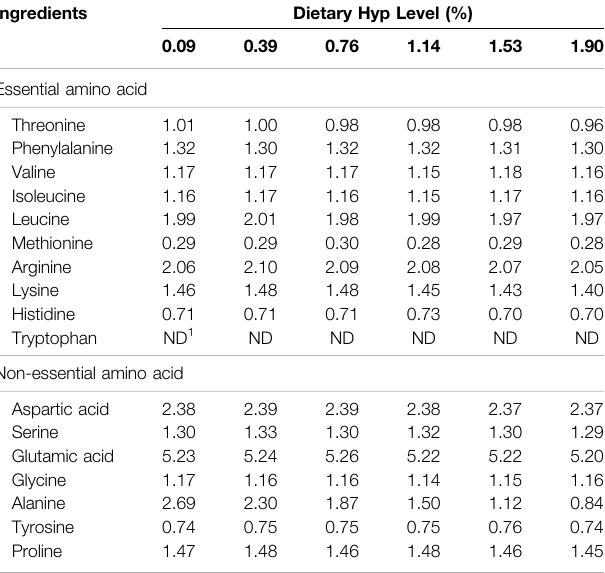
TABLE 2 | Amino acid pro fi le of the experimental diets for 8 weeks (% dry matter).